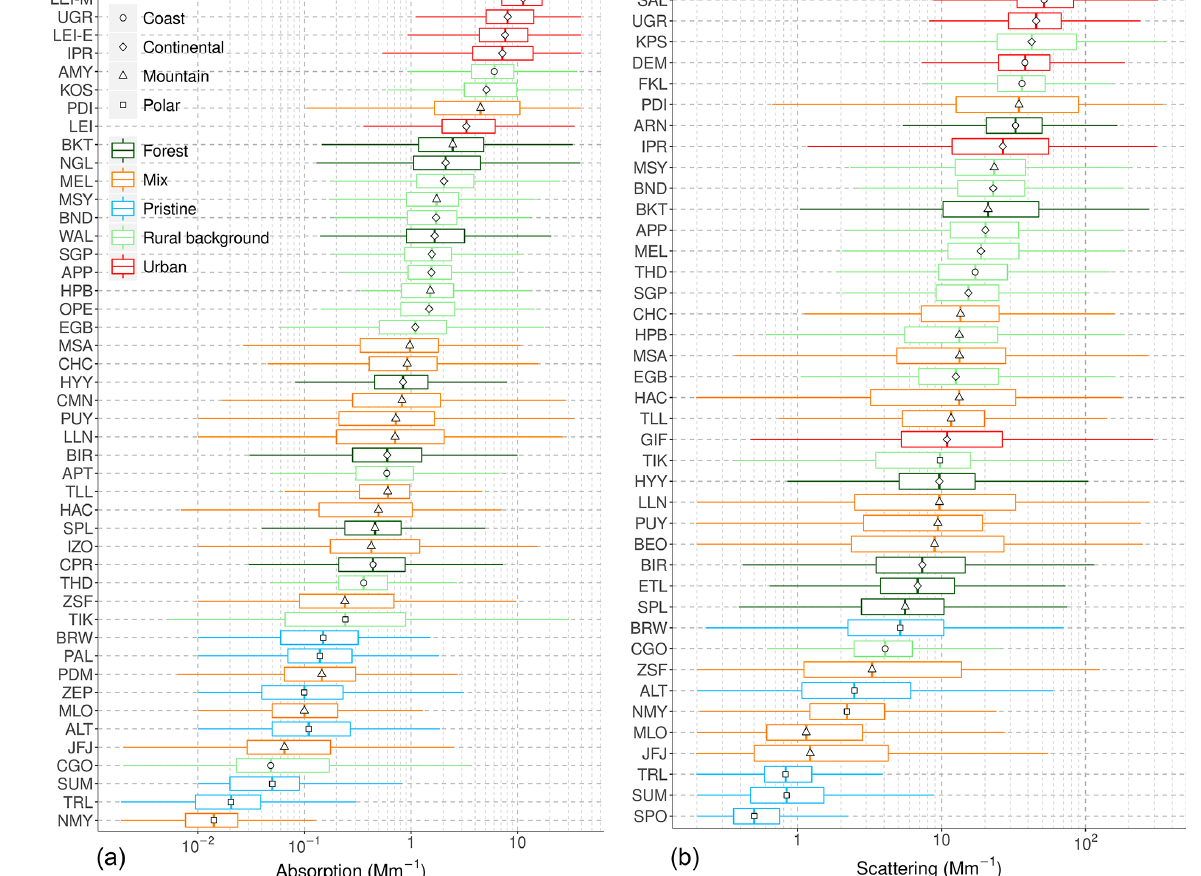
Figure 5. Boxplot of hourly aerosol absorption (a) and scattering (b) coefficients at the SARGAN sites with sufficient annual coverage over the considered period (see summary Tables S1 and S2 for details). Boxplot colour indicates the footprint and the symbol at the median indicates the geographical category; both colour and symbol follow Table